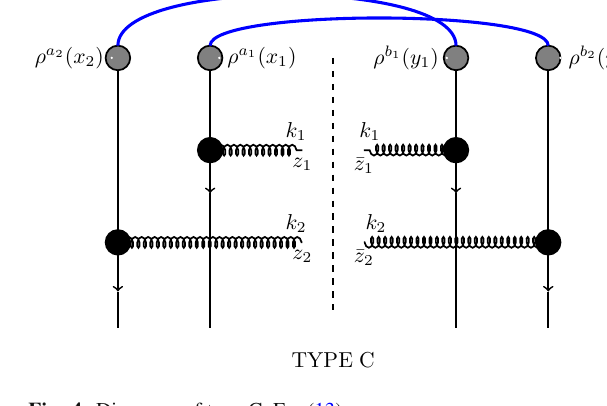
Fig. 4 Diagrams of type C, Eq.